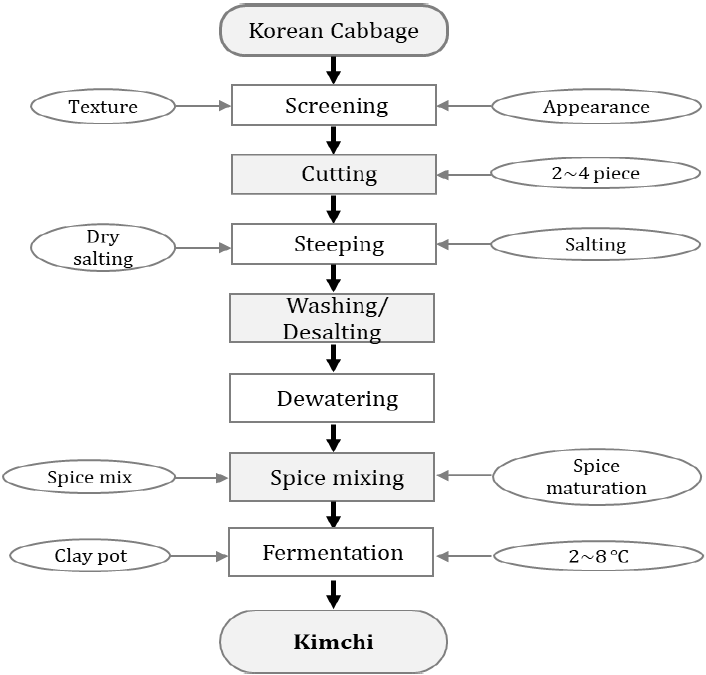
Figure 2. Simple manufacturing process of Korean cabbage kimchi .